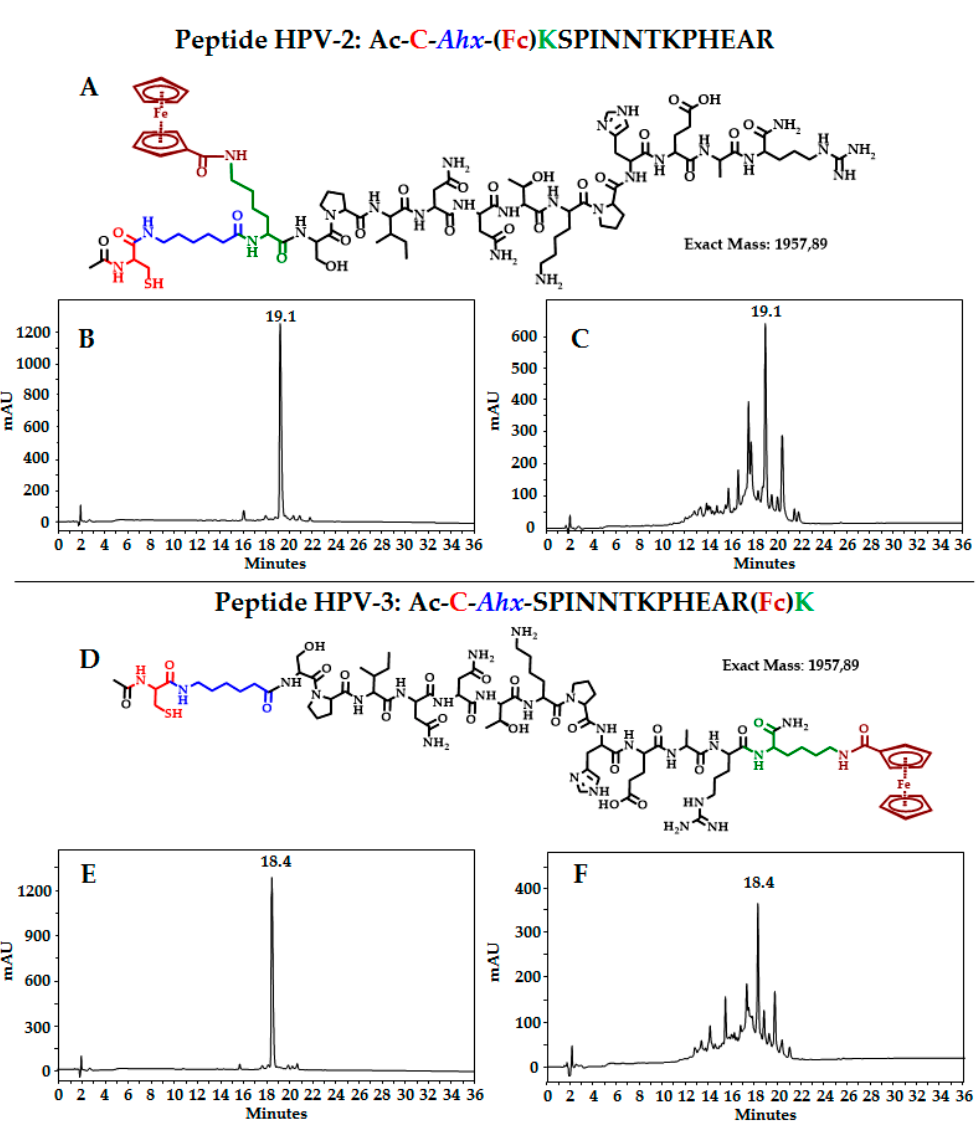
Figure 1. Peptides derived from Human Papillomavirus L1 protein (HPV L1). Both sequences contain (i) a cysteine residue (in red); (ii) an aminohexanoic residue (in blue); (iii) lysine residue (in green); and (iv) the ferrocene motif (in brown). Structure of peptide HPV-2: ( A ) reverse phase high performance liquid chromatography (RP-HPLC) profile of the purified product ( B ) before, and ( C ) after the lyophilization process. Structure of peptide HPV-3: ( D ) RP-HPLC profile of the purified product ( E ) before and ( F ) after the lyophilization process.